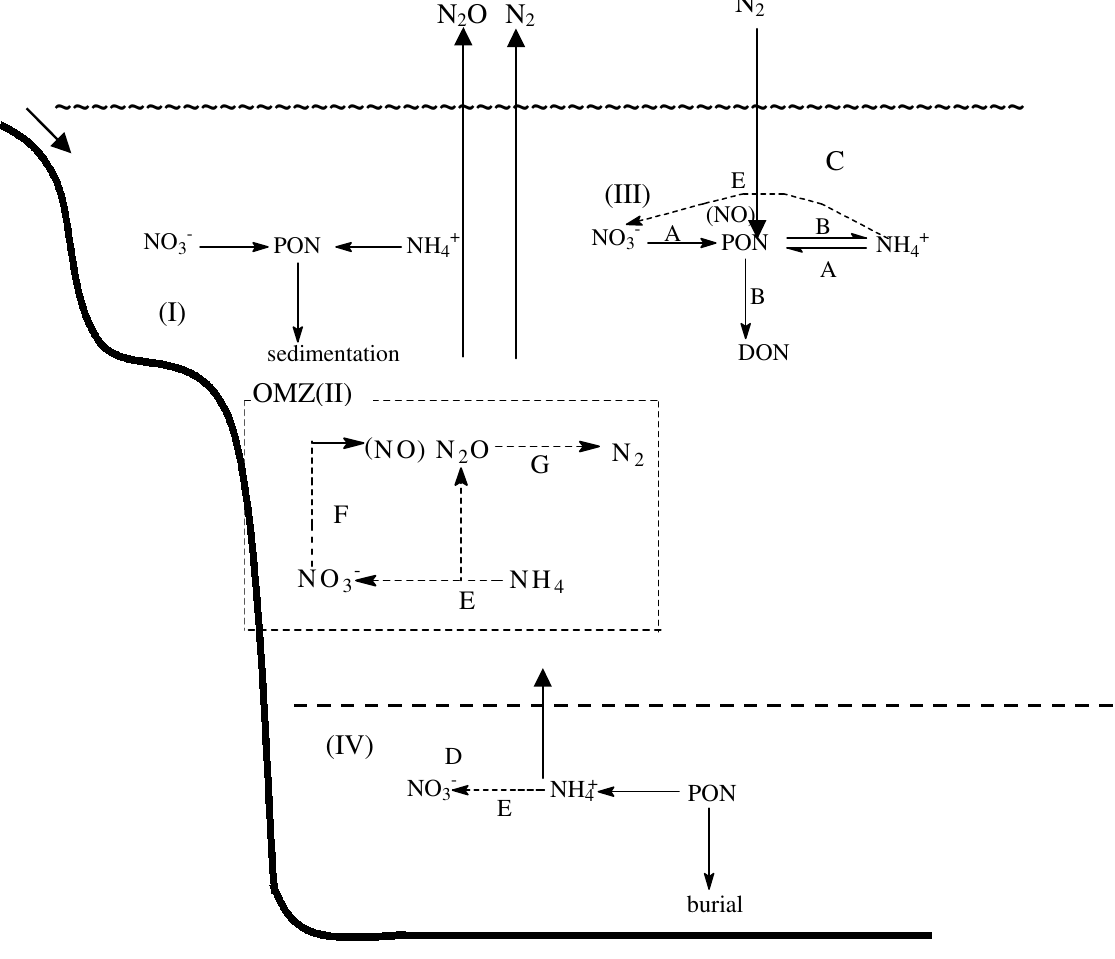
Fig. 6 . Conceptual diagram of major features of the nitrogen cycle in coastal shelf and upwelling ( I ) ,OMZ (II), surface waters of the open ocean (III), and deepwater(IV). PON, particulate organic nitrogen. Dashed lines indicate transformations involving multiple steps. Pathways: A, DIN assimilation; B, ammonium regeneration; C, nitrogen fixation; D, nitrate diffusion/advection from deep water; E, nitrification; F, nitrification; G,